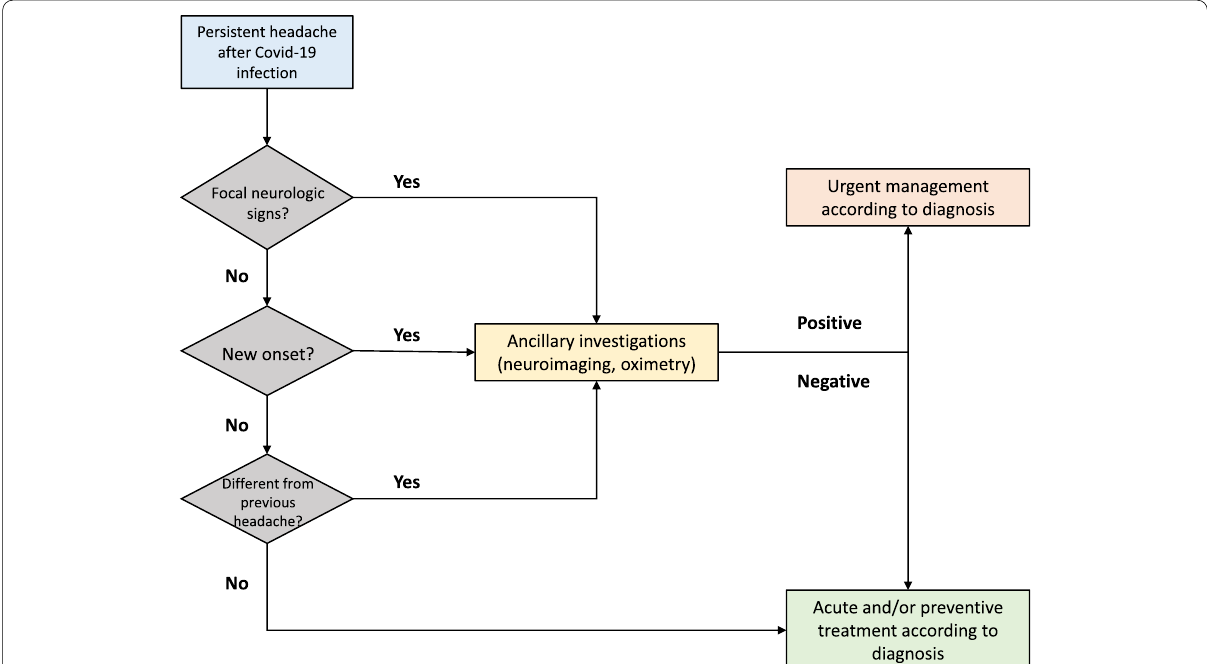
Fig. 2 A proposed algorithm for the diagnosis of long COVID